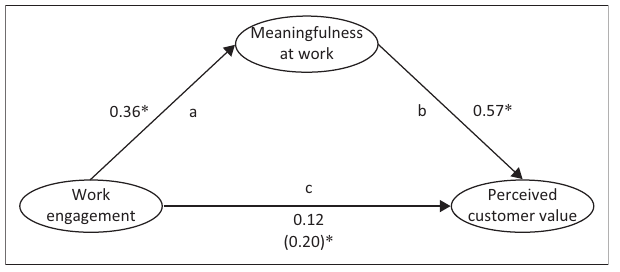
FIGURE 2 : Simple mediation model: Work engagement, meaningfulness at work and perceived customer